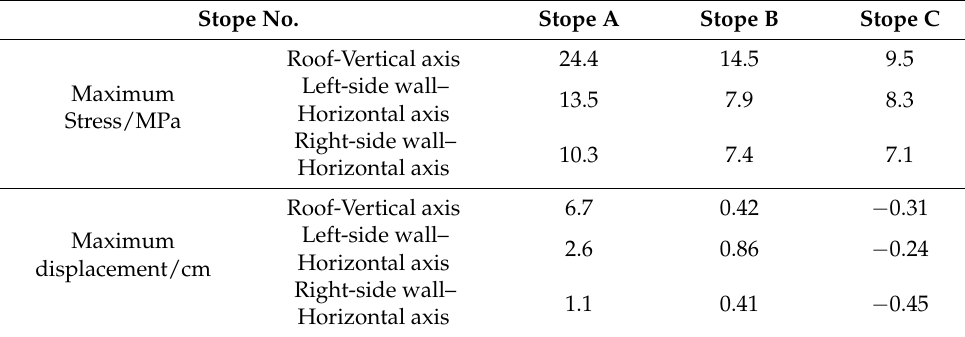
Table 2. The maximum displacement of each wall after the target stope is excavated. Stope No. Stope A Stope B Stope C